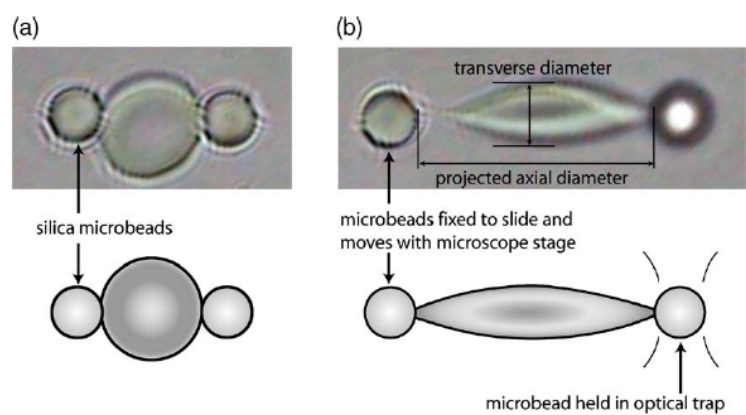
Fig. 1 Using optical trap or laser tweezers to stretch a healthy RBC. Here, two silica microbeads of 4.12 µm in diameter are non-specifically attached at diametrically opposite points of a RBC. (a) For this unstretched RBC, the left bead is adhered to the glass slide surface. (b) As the right bead is trapped using the laser as shown by the lighted up bead, it is held stationary while the glass slide is moved towards the left thus stretching the cell.